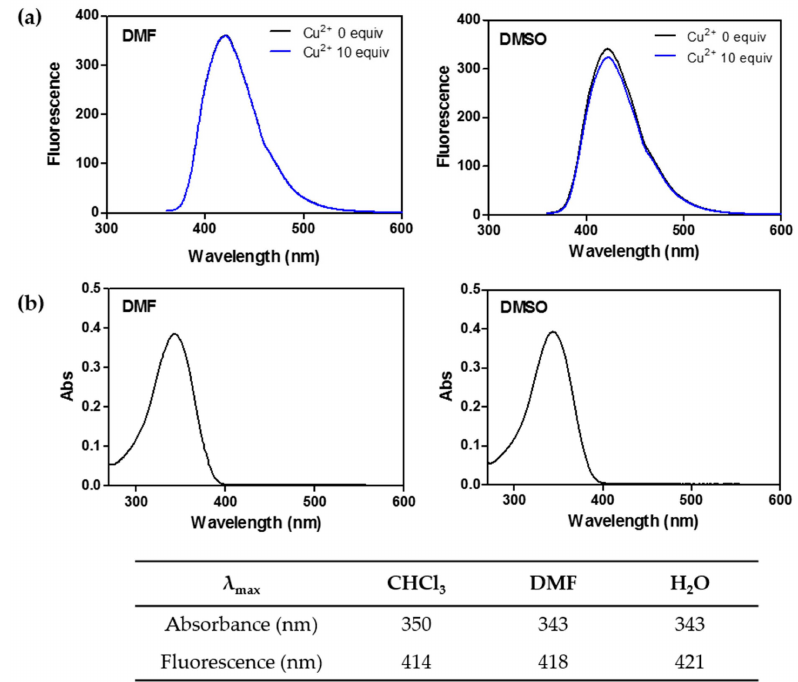
Figure 7. Spectroscopic features of 7-methoxy coumarin-peptoid ( CP4 ) as a control. ( a ) fluorescence spectra of CP4 (1 µ M) in response to the presence of Cu 2+ (0 to 10 µ M) in DMF and DMSO ( λ ex = 343 nm, λ em = 418 nm, slit widths = 3 nm for excitation and 5 nm for emission); ( b ) absorption spectra of CP4 (50 µ M) in DMF and DMSO ( λ max = 343